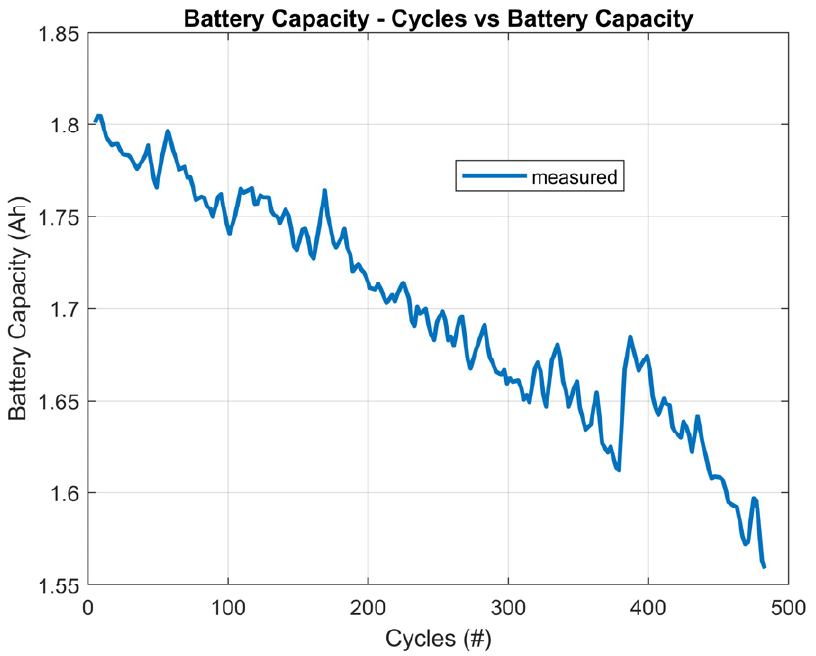
Figure 2. B036 dataset: measured battery capacity at the end of each discharge cycle [22].